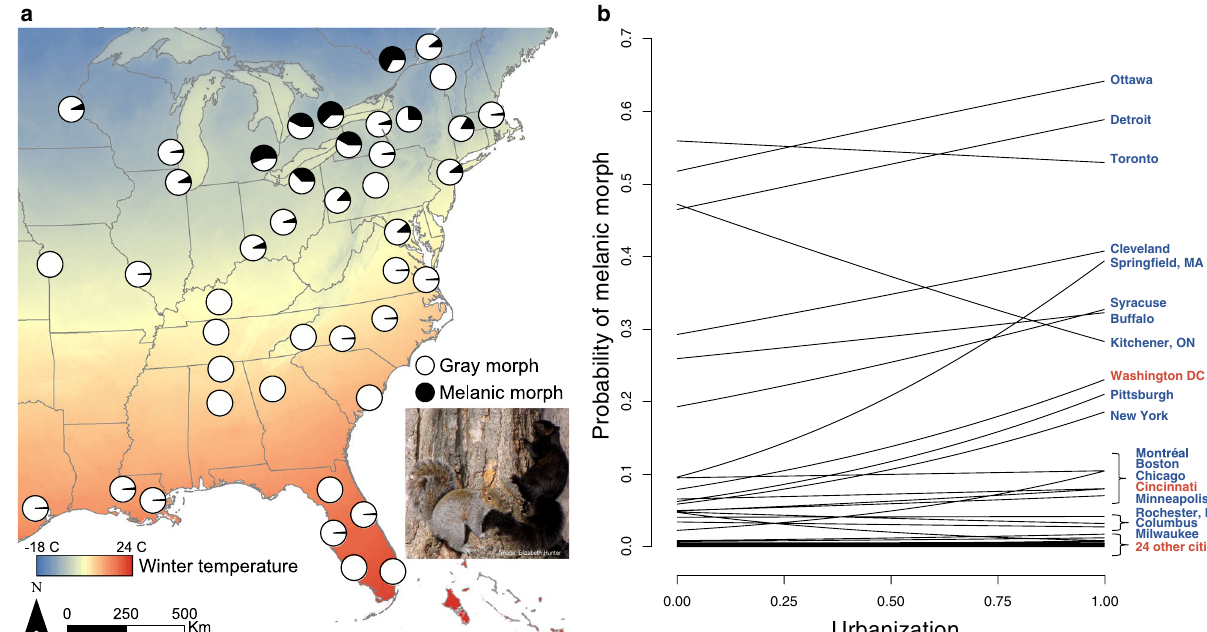
Figure 1. ( a) Distribution of coat color morphs of 26,924 eastern gray squirrels ( Sciurus carolinensis ) among 43 cities in North America. Pie charts show the proportion of melanic and gray color morphs in each city. Gray morph included rare color morphs that accounted for 2% of observations (Supplementary Table 1). ( b) Clines in melanism along urbanization gradients in each city. Urbanization was measured as standardized impervious cover. Regression lines represent predicted effect of urbanization on melanism in each city based on a linear mixed model including effects of city size, forest cover, and winter temperature (Fig. 2, Supplementary Table 2). City names are color-coded to show winter temperatures above (red) and below (blue) the median winter temperature. Map was created in ArcMap 10.5.1. Photo by Elizabeth